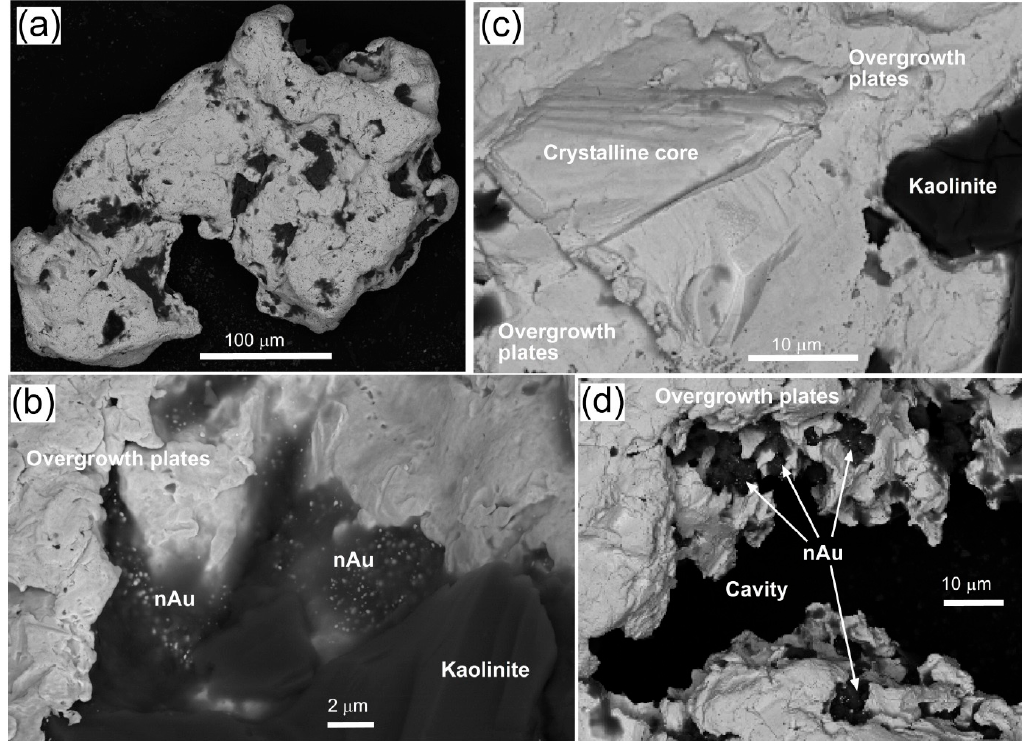
Figure 6. SEM backscatter electron images of surface features of detrital gold from Miocene quartz pebble conglomerate from the St Bathans area. ( a , b ) Gold from Pennyweight excavation, with overgrowth plates and nanoparticulate gold (nAu) intergrown with kaolinite; ( c , d ) Gold from Blue Lake excavation showing overgrowth plates on a crystalline core, with delicate overgrowth plates extending into an open